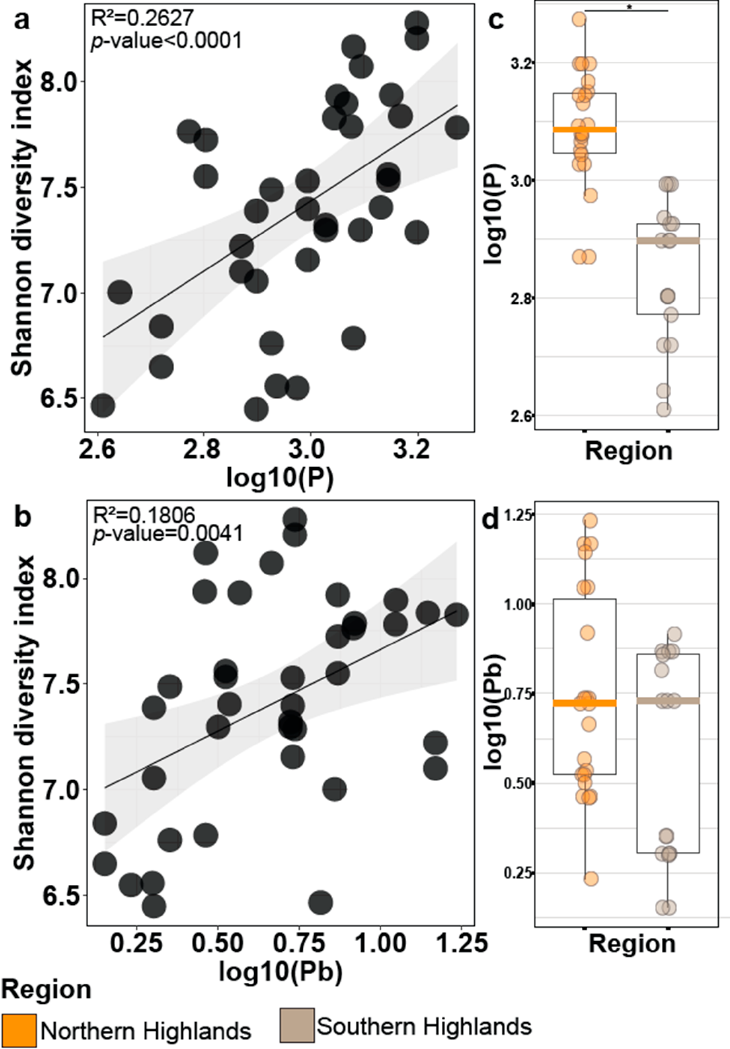
Figure 4. Phosphorous and lead drive relationship between Shannon diversity index of the bacterial rhizosphere and soil regions. Dispersion graph and regression analysis of Shannon diversity index versus phosphorous ( a ) and lead ( b ). Regression coefficient (R 2 ) and the significance ( p -value) are presented for each factor. Boxplot of phosphorous ( c ) and lead ( d ) concentration found in the three soil regions. * represents significant differences using t -Student test ( p -value < 0.001).